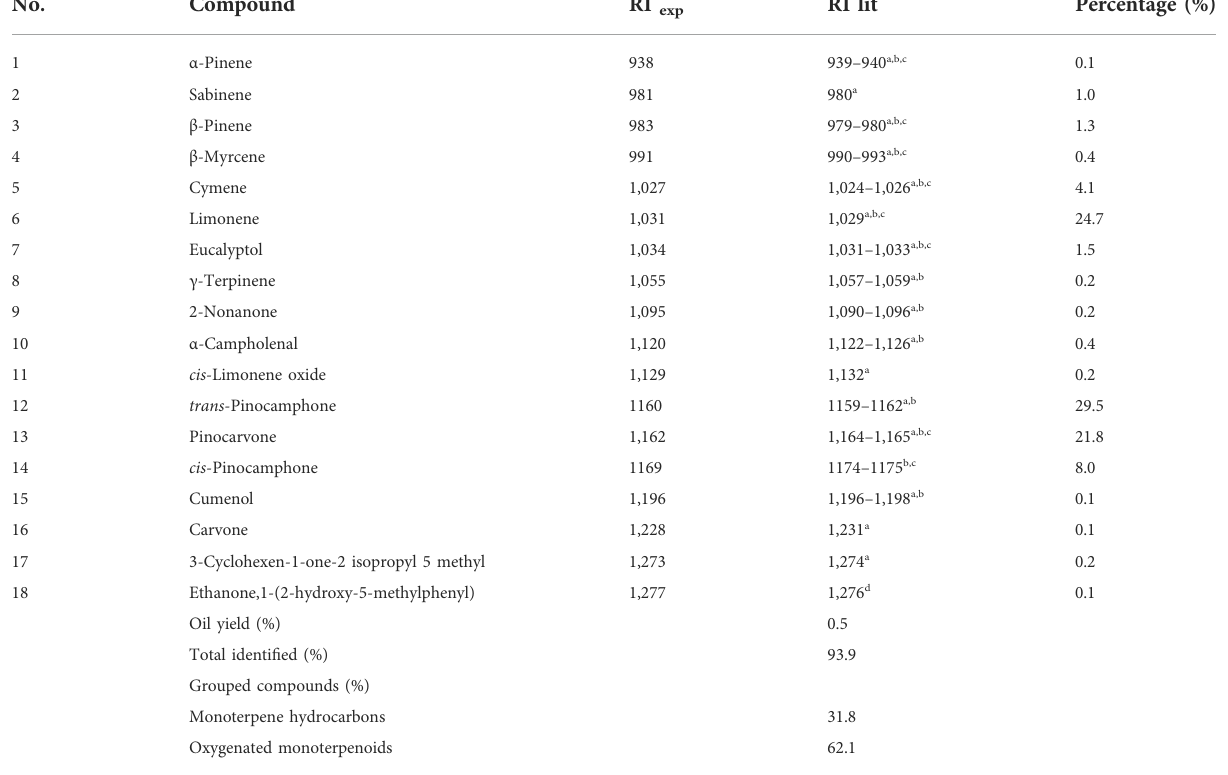
TABLE 1 The chemical composition of the essential oil of A. porophyllum var. cancellatum .